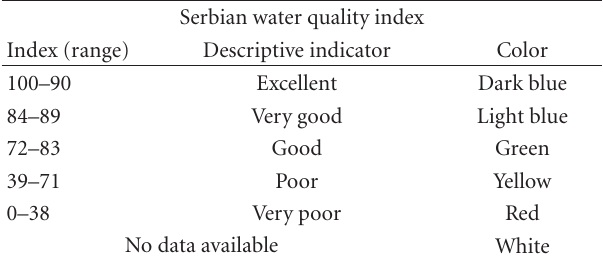
Table 2: The SWQI surface water quality